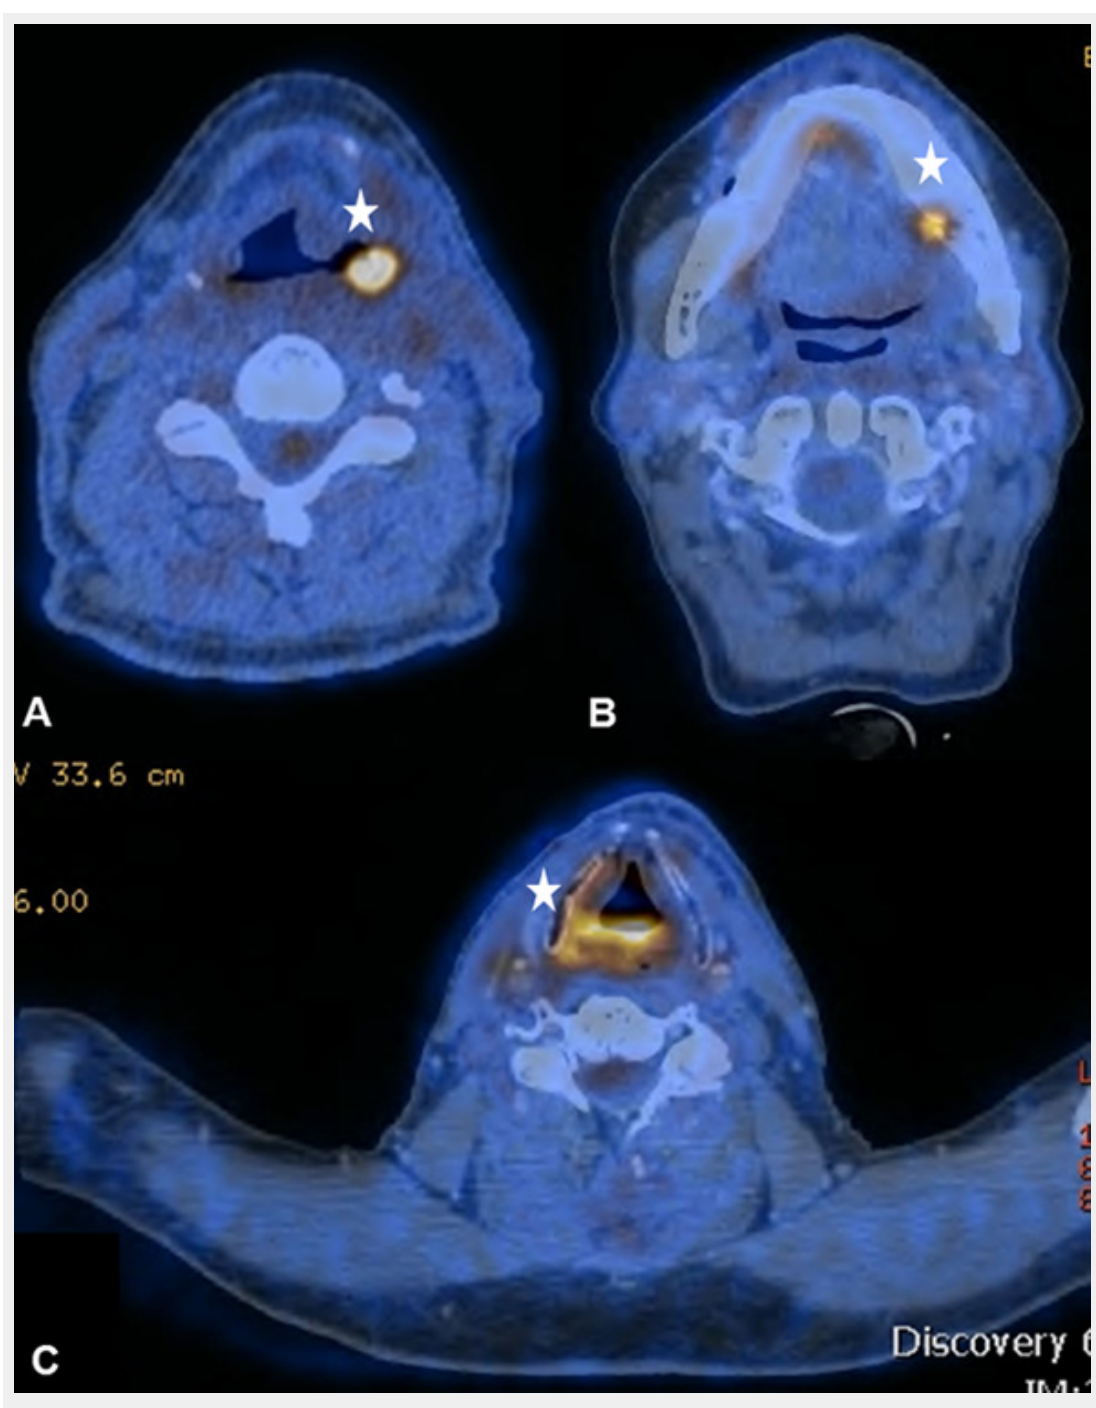
Figure 7 (A) Sixty-two year old patient after curative radio-chemotherapy (RCT) for a supraglottic larynx carcinoma with increased focal uptake in the left hypopharynx due to a radiogenic ulcer. (B) Increased focal uptake of the left mandible due to osteoradionecrosis in a 48-year old patient after curative RCT for an oropharynx carcinoma (C) Radiogenic chondronecrosis of the corniculate cartilages in a 59-year old patient after surgical resection and radiation therapy of a base of tongue